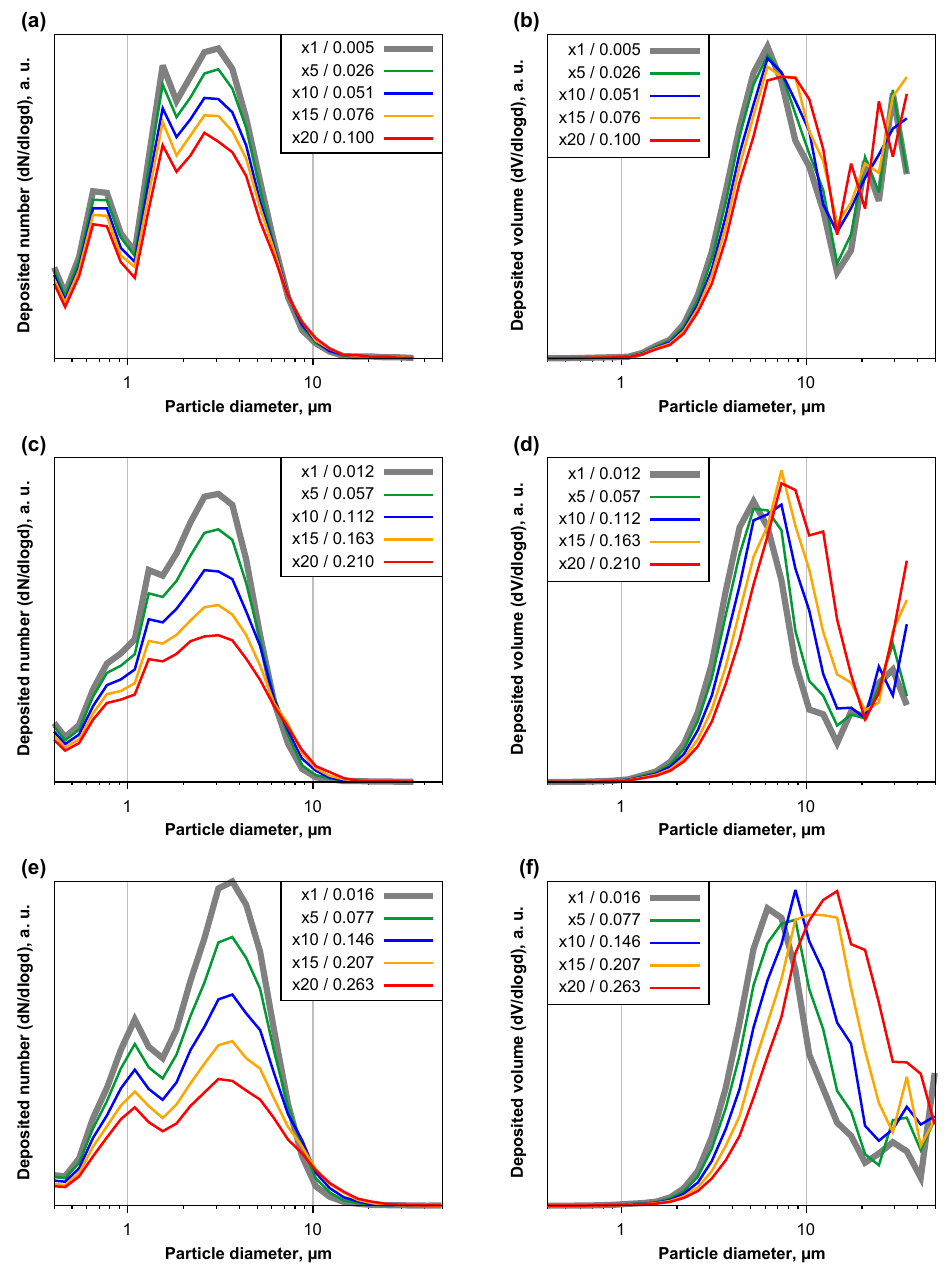
Figure 6. Number (a, c, e) and volume size distributions (b, d, f) of deposited particles measured at Ragged Point and extrapolated change as function of particle projected area diameter and area coverage fraction, simulating a longer exposure time. Plots are given for low (a, b) , medium (c, d) and high (e, f) base coverages. Different colors show different factors of exposure increase (5 × , 10 × , 15 × , 20 × ). Resulting coverage fractions are given in the figure